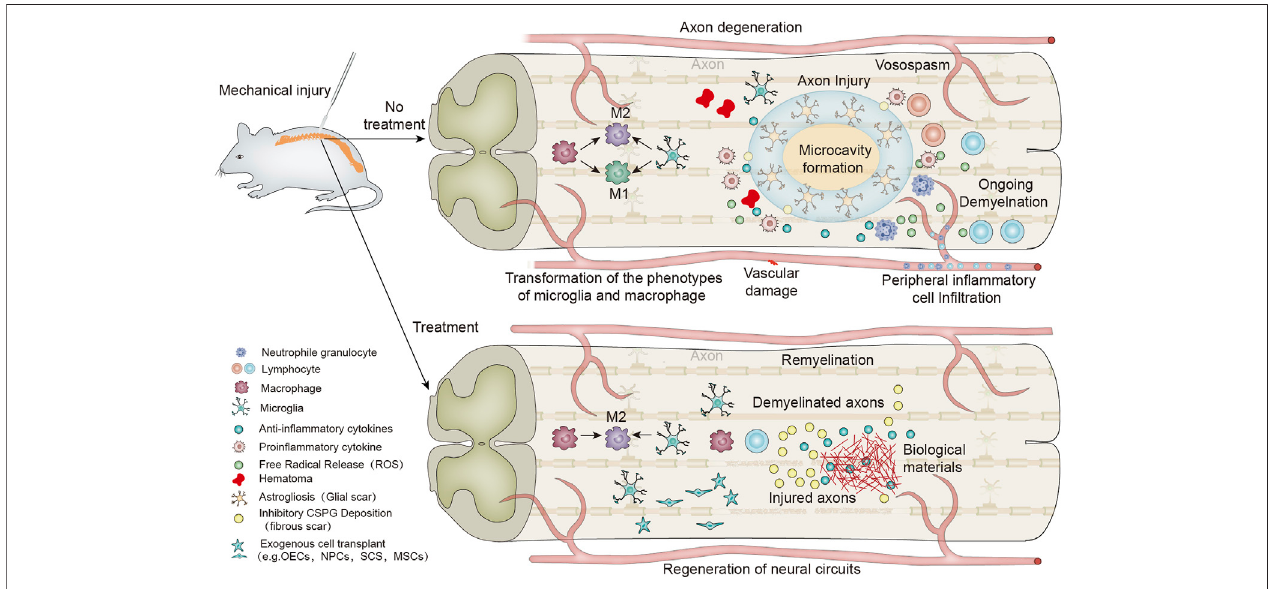
SCHEME 1 | Schematic diagram of biomaterials regulating the local immune microenvironment after spinal cord injury and promoting nerve regeneration and myelination.